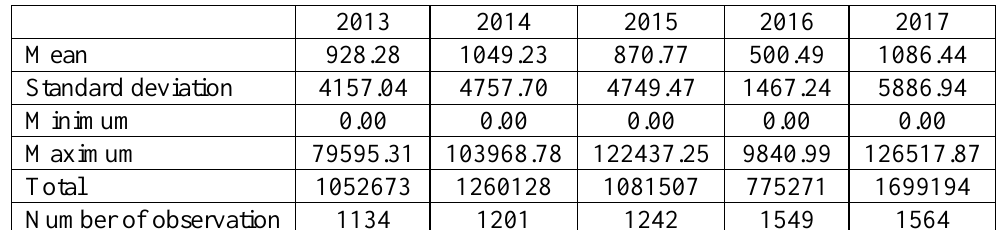
Table 8 posits the descriptive statistics of betweenness centrality. Table 8. Descriptive statistics of